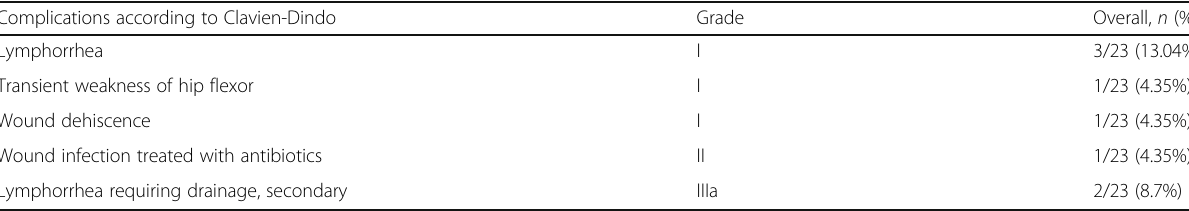
Table 2 Complications arising from 23 lymphadenectomies Complications according to Clavien-Dindo Grade Lymphorrhea Transient weakness of hip flexor Wound dehiscence Wound infection treated with antibiotics Lymphorrhea requiring drainage,